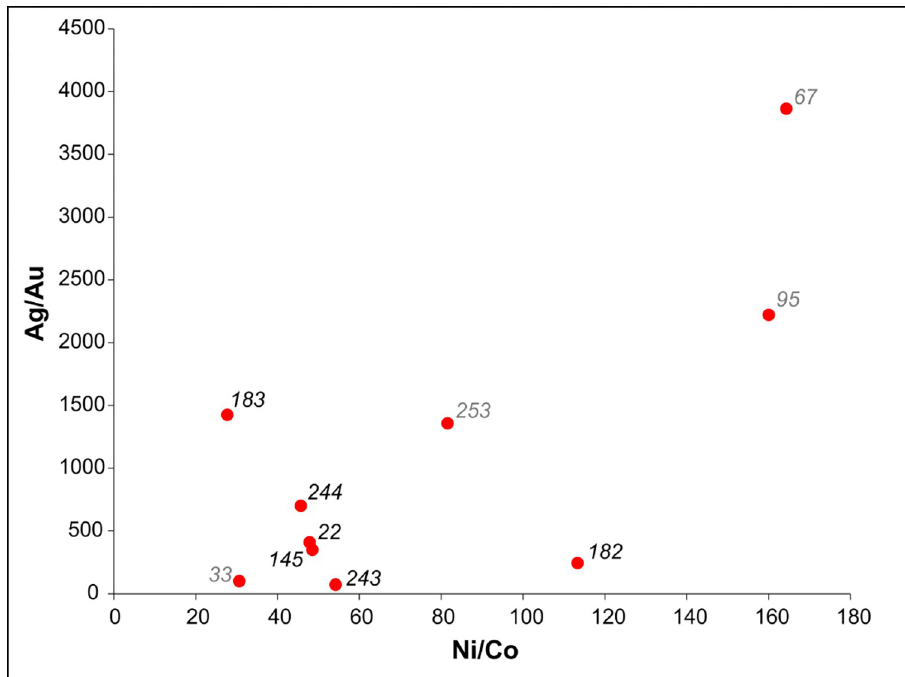
Fig 18. The silver/gold (Ag/Au) ratio versus the nickel/copper (Ni/Co) ratio.